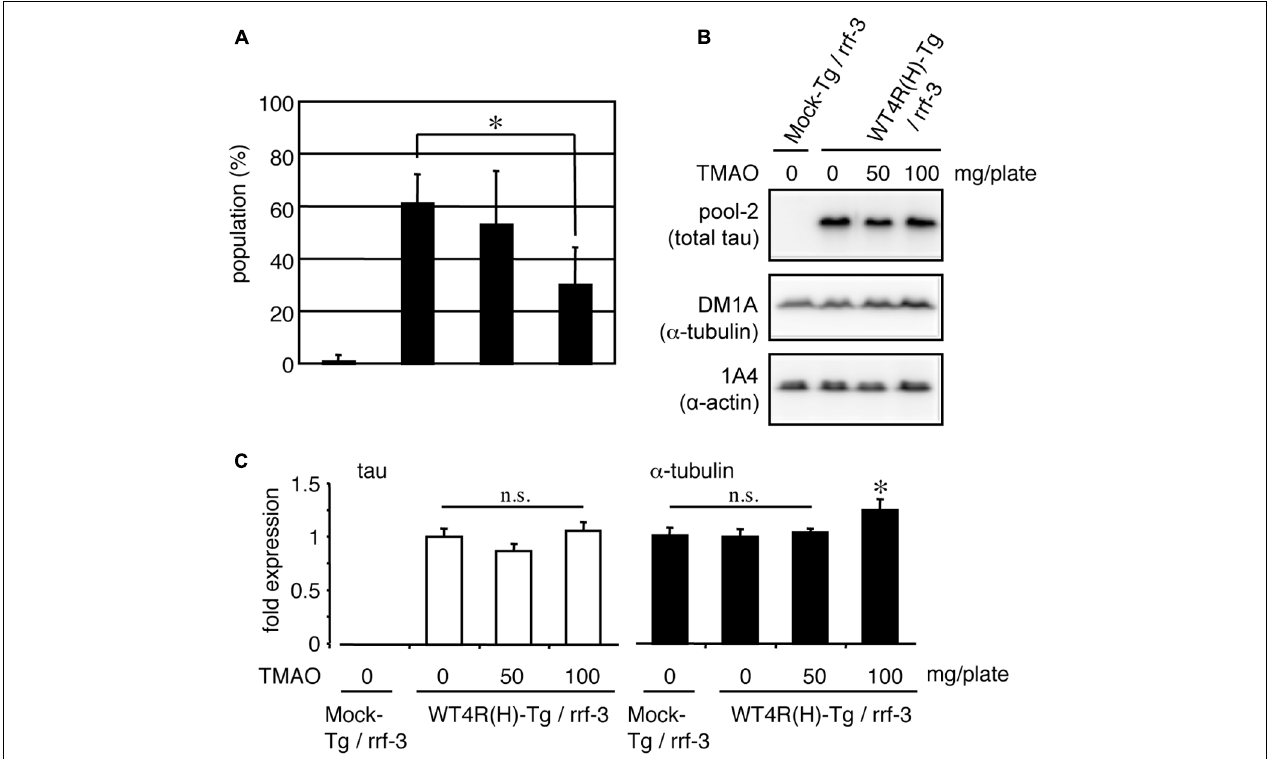
FIGURE 8 | TMAO improves behavioral phenotypes of tau-expressing worms. (A) Mock-Tg or WT4R(H)-Tg worms were treated with TMAO for 4 days and evaluated for Unc. The data indicate the populations of severely affected worms (means ± SEM, n = 5). (B) Total lysates from TMAO treated worms were analyzed by Western blotting using antibodies indicated. (C) The amounts of tau and α -tubulin were quantified (means ± SEM, n = 7). Statistical significance was analyzed by Tukey’s post hoc test ( ∗ p < 0.05 ).